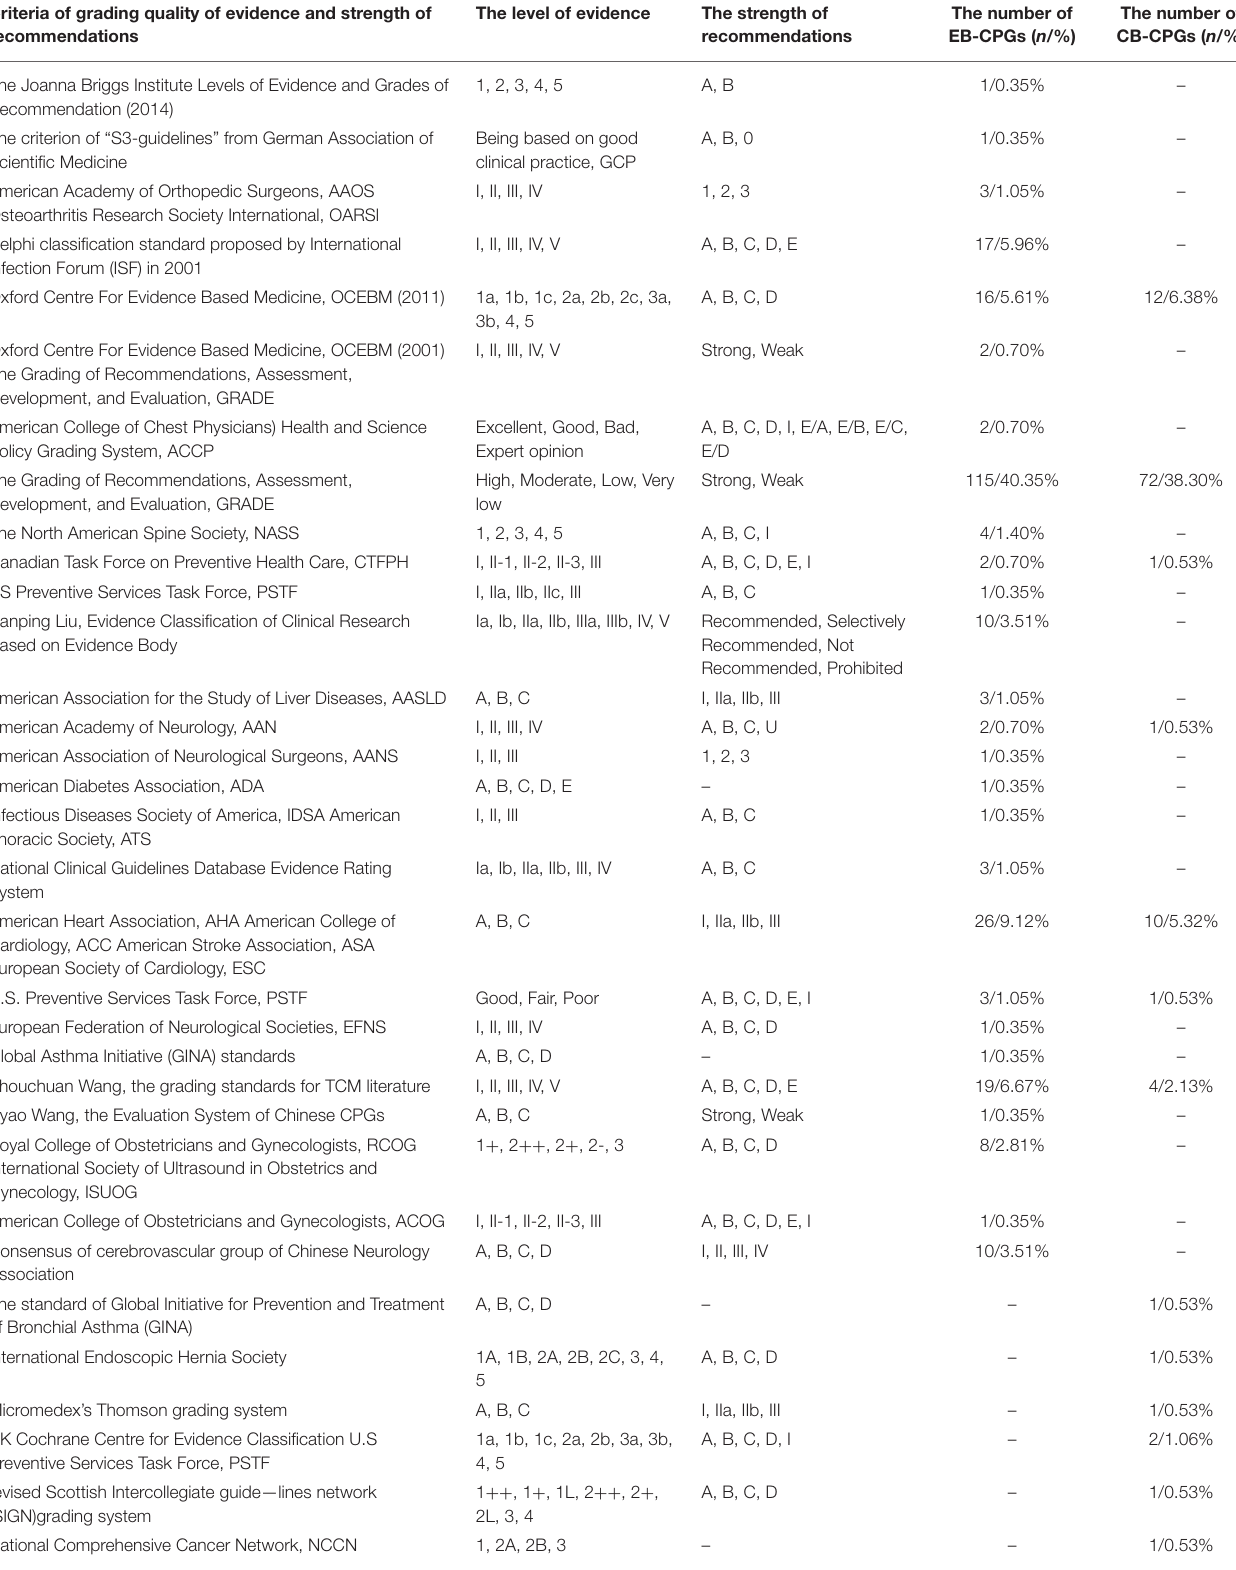
TABLE 1 | Criteria used in the published guidelines from 2010 to